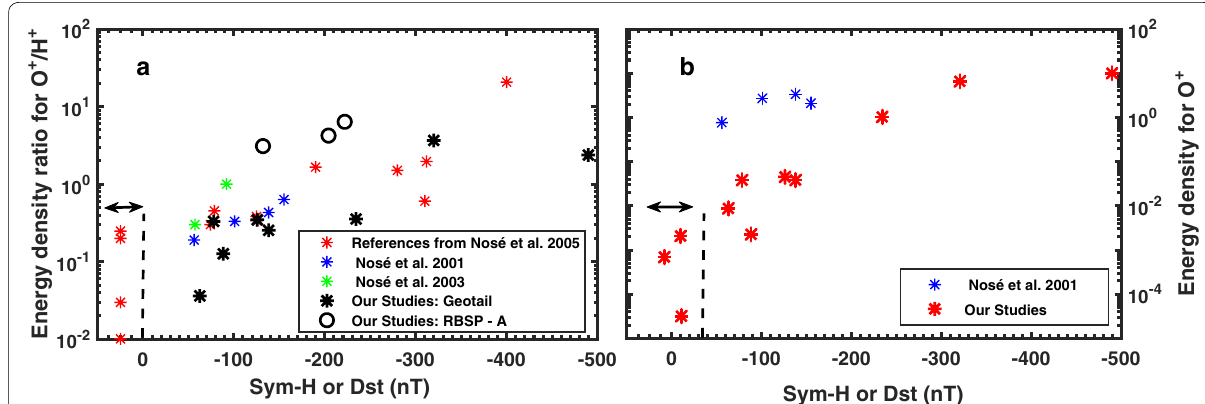
Fig. 11 Summary plot using Geotail observations ( a ) showing dependence of O + /H + energy density ratio on Sym-H or Dst in the ring current and the plasma sheet. Red, blue and green data points correspond to the energy density ratio reported from previous studies and references there in Nosé et al. (2005, 2001, 2003), respectively. The data points represented in black are outcome from this study. Black vertical dashed line at 0 nT is the boundary for quiet interval. b The energy density variation of O + ions with respect to Sym-H or Dst. The blue data points correspond to the energy density values measured by Nosé et al. (2001) while red data set corresponds to the energy density values measured in this study. The quiet interval is considered above 25 nT, shown by black vertical dashed −